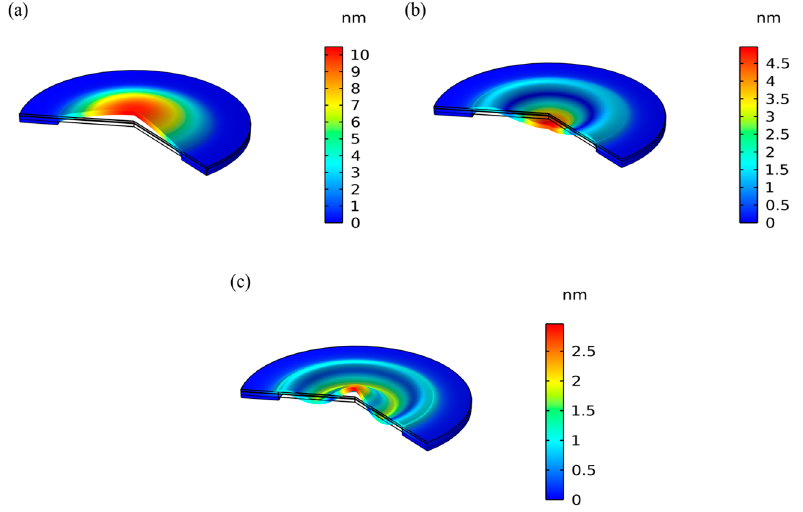
Figure 4. The first three modes of bending vibration: ( a ) the first-order bending vibration mode; ( b ) the second-order mode; ( c ) the third-order mode.